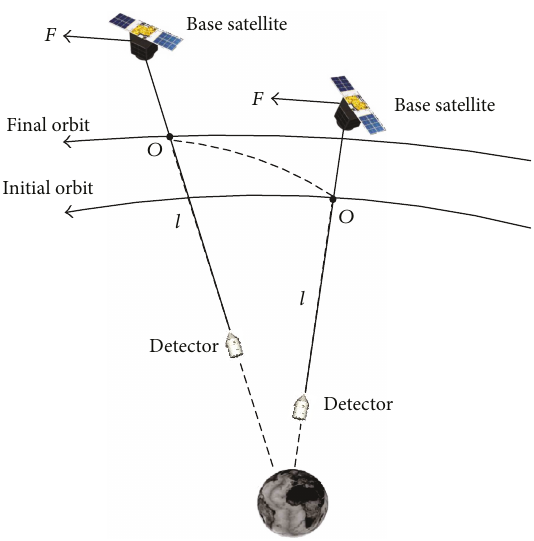
Figure 2: Description of an optimal control